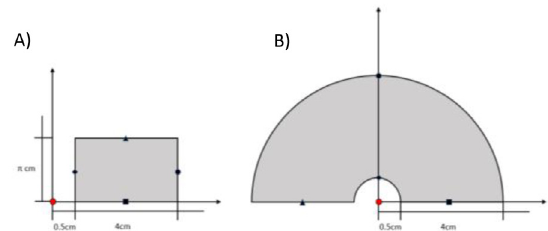
Fig. 2. Conformal mapping in virtual space (A) and its transformation into real space